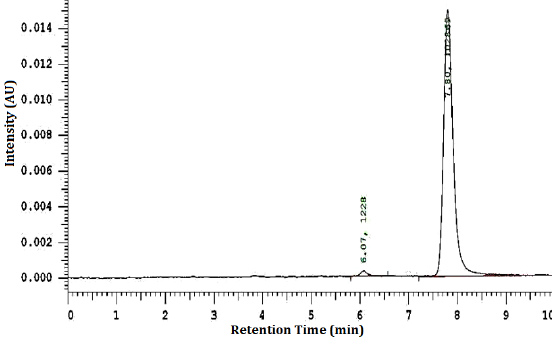
Figure 4. Chromatogram of piperine reference sub- stance at 340